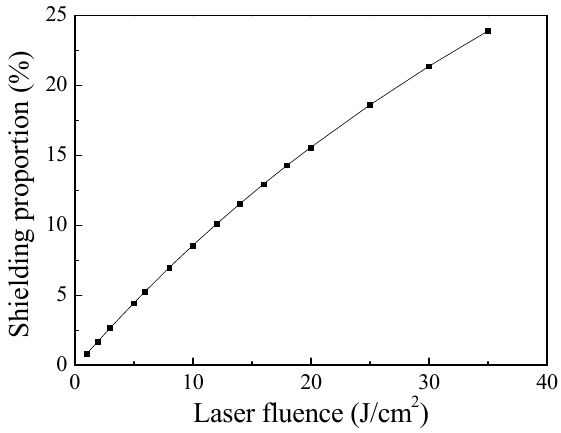
Figure 3. Variation of plasma shielding proportions with laser fluence.